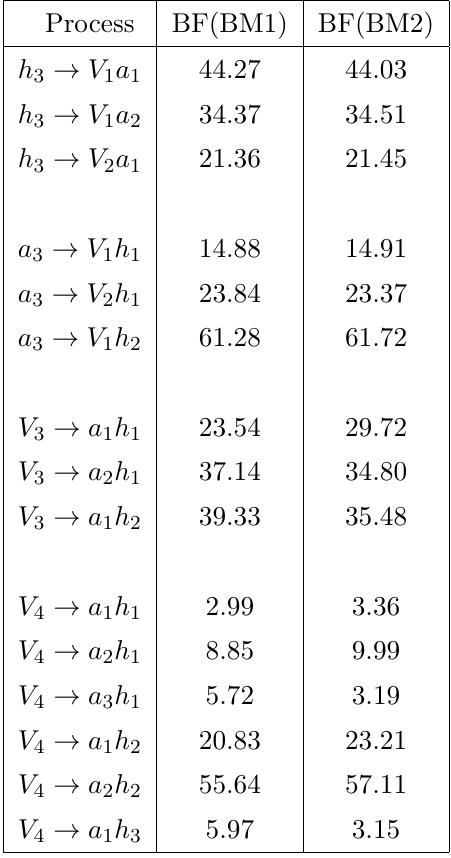
Table 5 . Branching fractions for the various decay modes in per cent for the next highest gauge and h; a KK states in both BM scenarios as discussed in the